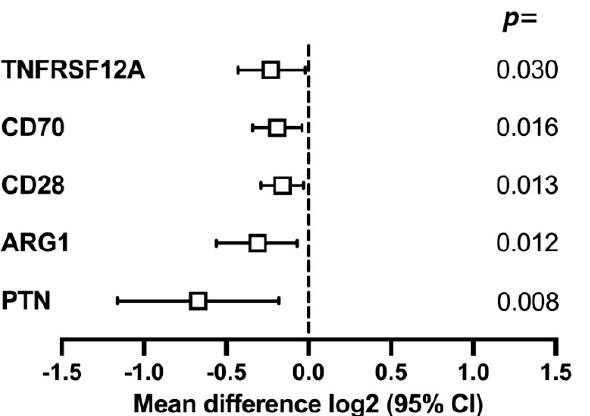
Figure 1. Forest plot on the effect of the p16 status on protein expression at baseline. Bars represent the confidence interval (CI), and the box represents the median.